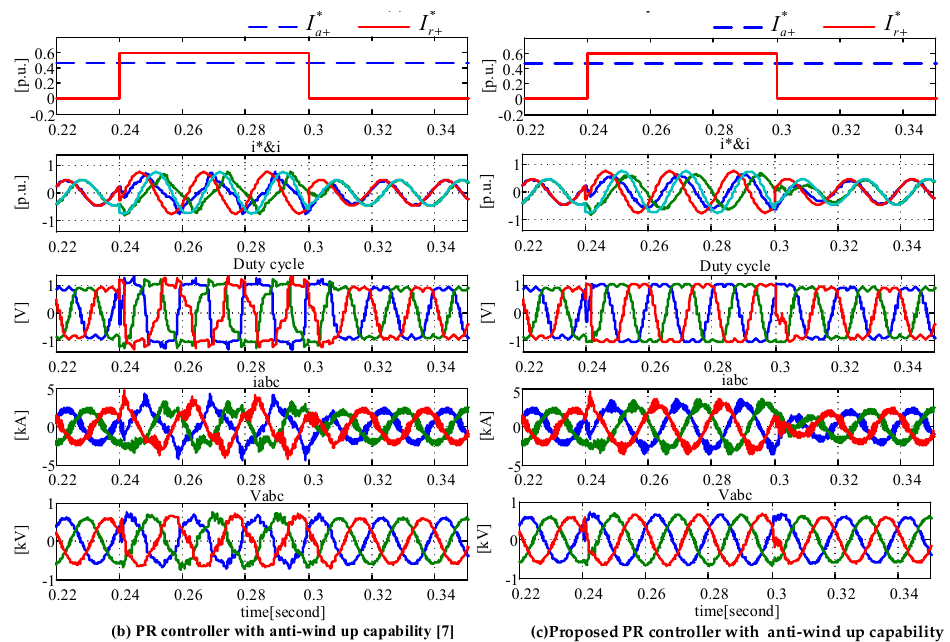
Figure 15 . The Real Time Simulation results of inverter with different PR controller for SCR = 5. From top to bottom: in first figure active and reactive current references; in second figure actual and reference currents in αβ axes; in third figure duty cycle; and in fourth figure converter current and in fifth figure PCC voltage.